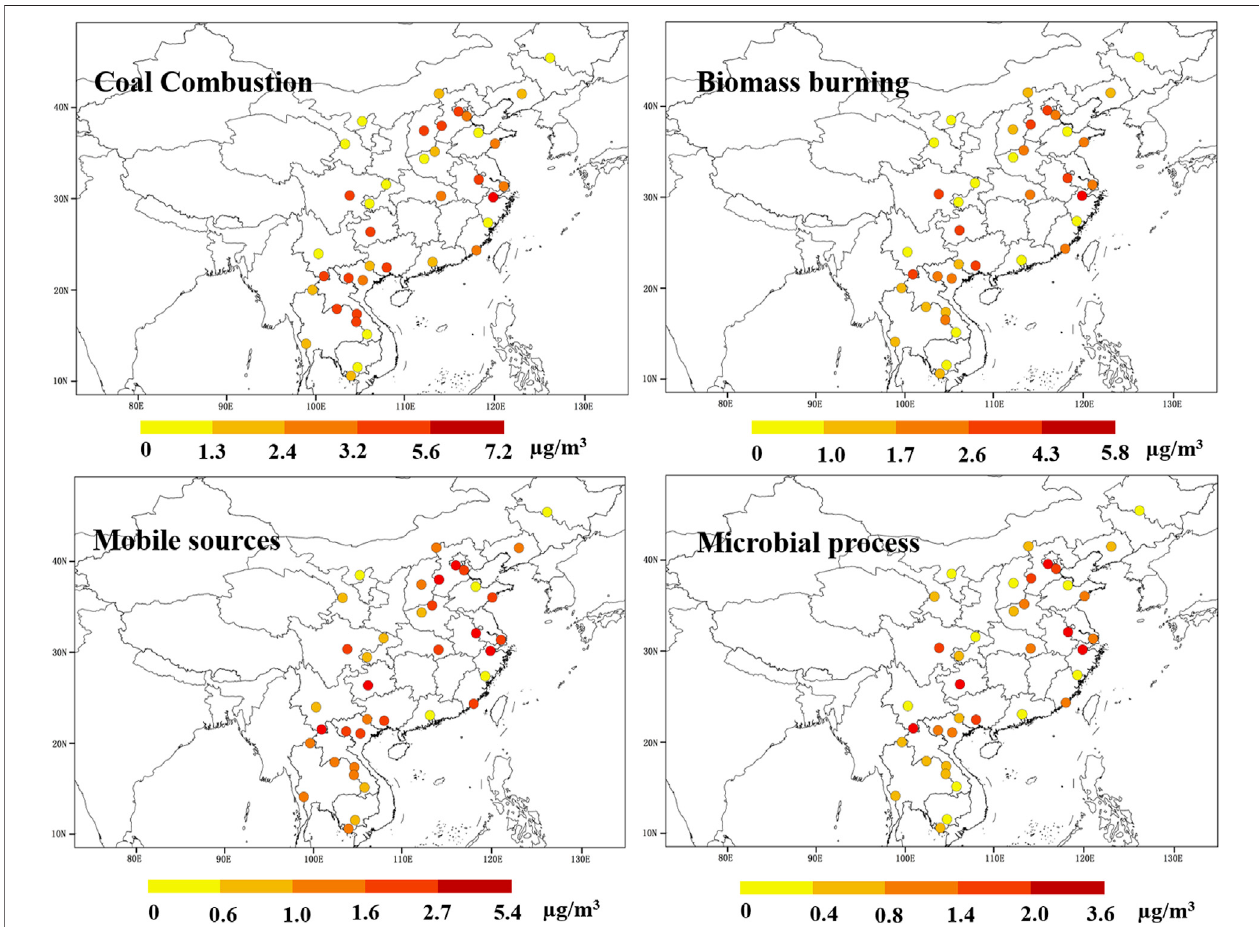
FIGURE 4 | Source-divided NO 3 − concentrations of coal combustion, biomass burning, mobile sources, and microbial processes at the 38 sampling sites in the CICP.